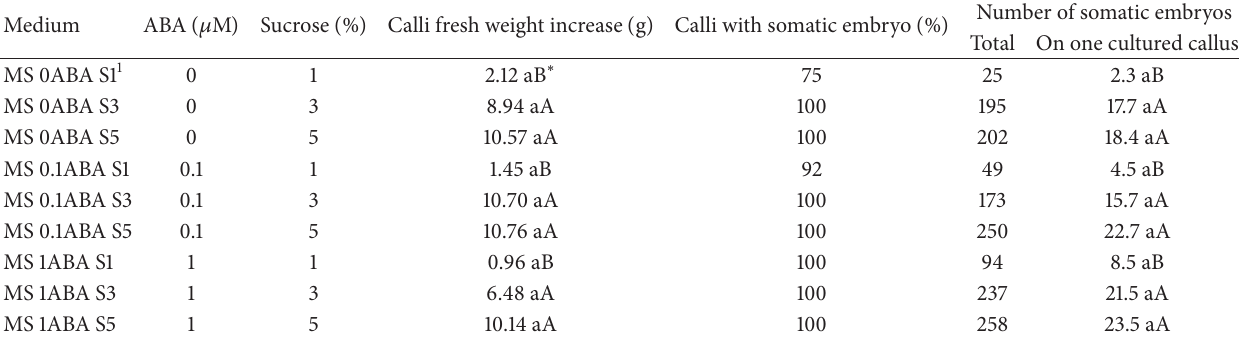
Table 4: Influence of ABA and sucrose contents on indirect somatic embryogenesis of C. tenuissima Ritt. forma monstruosa .